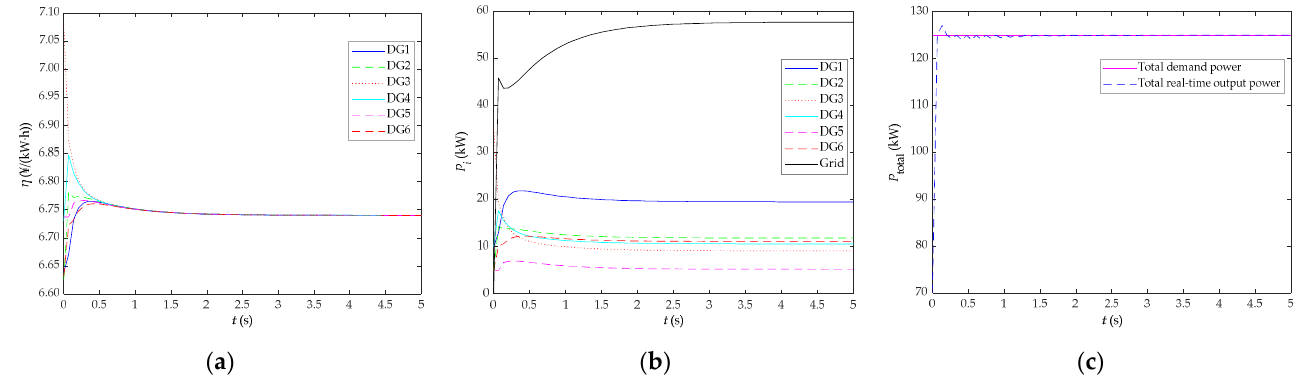
Figure 20. Communication topologies of low algebraic connectivity and high algebraic connectivity: ( a ) communication topology of low algebraic connectivity; ( b ) communication topology of high al- gebraic connectivity.